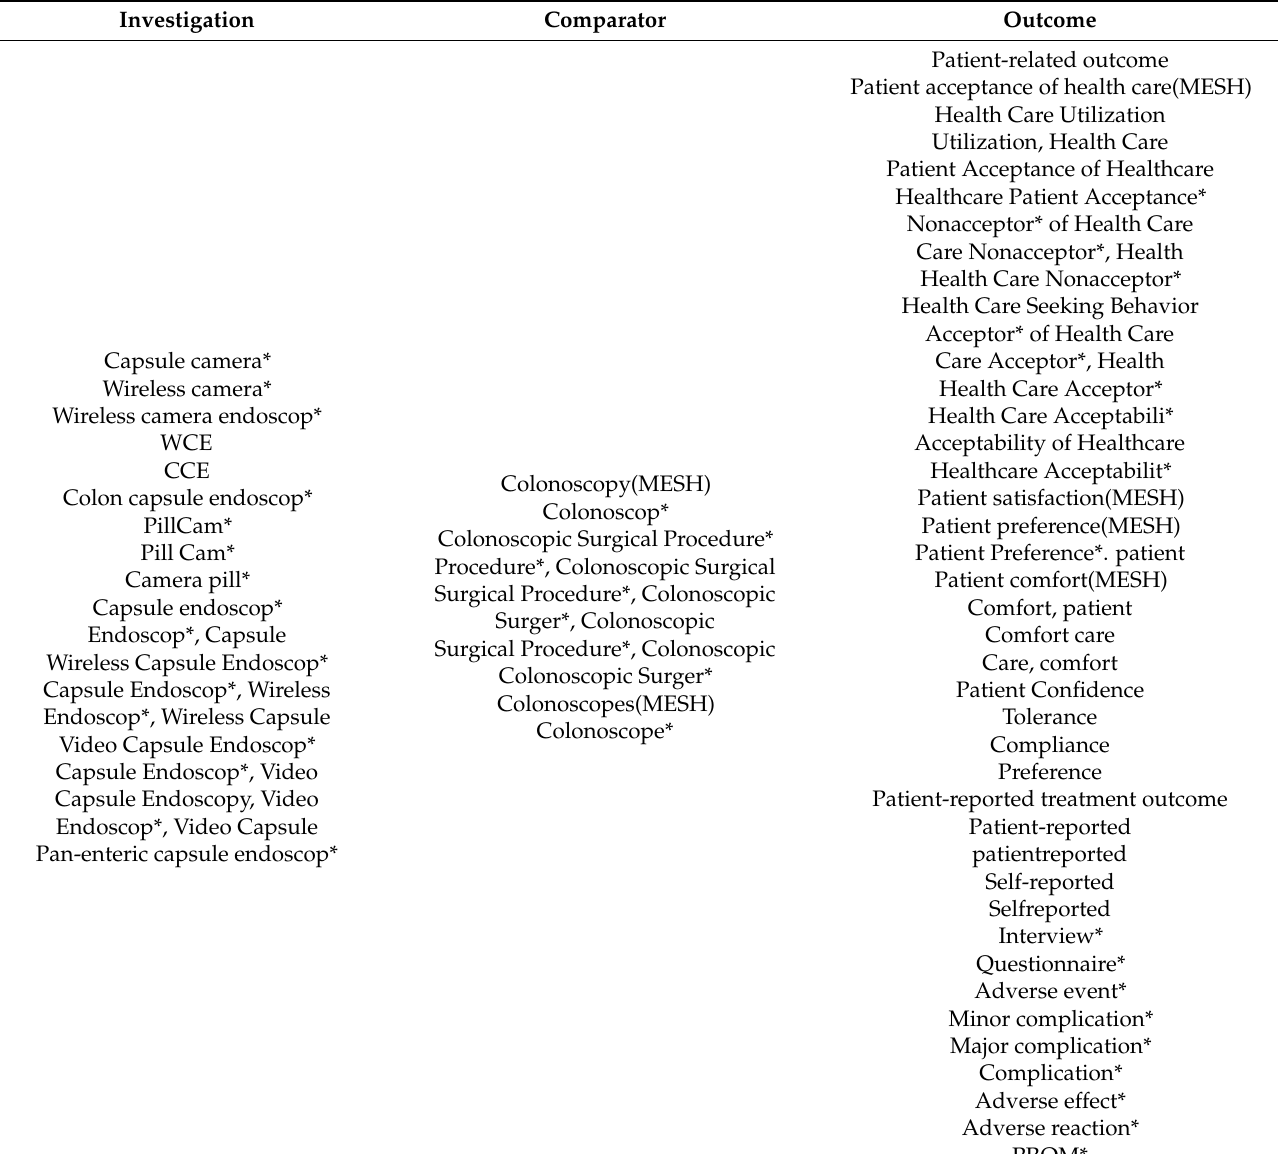
Table A1. Pico scheme search